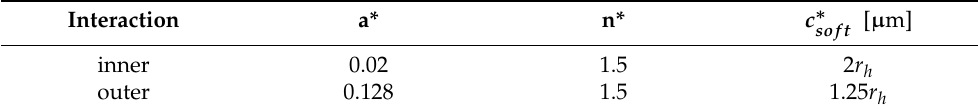
Table A4. Simulation parameters, interaction of the particle suspension with the membrane. Outer in- teraction of suspension in the drag force experiment. Inner interaction of particle suspension with cell membrane from the inside, both drag force Section 5.2.2 and RBC experiments Sections 6.1 and 6.2.